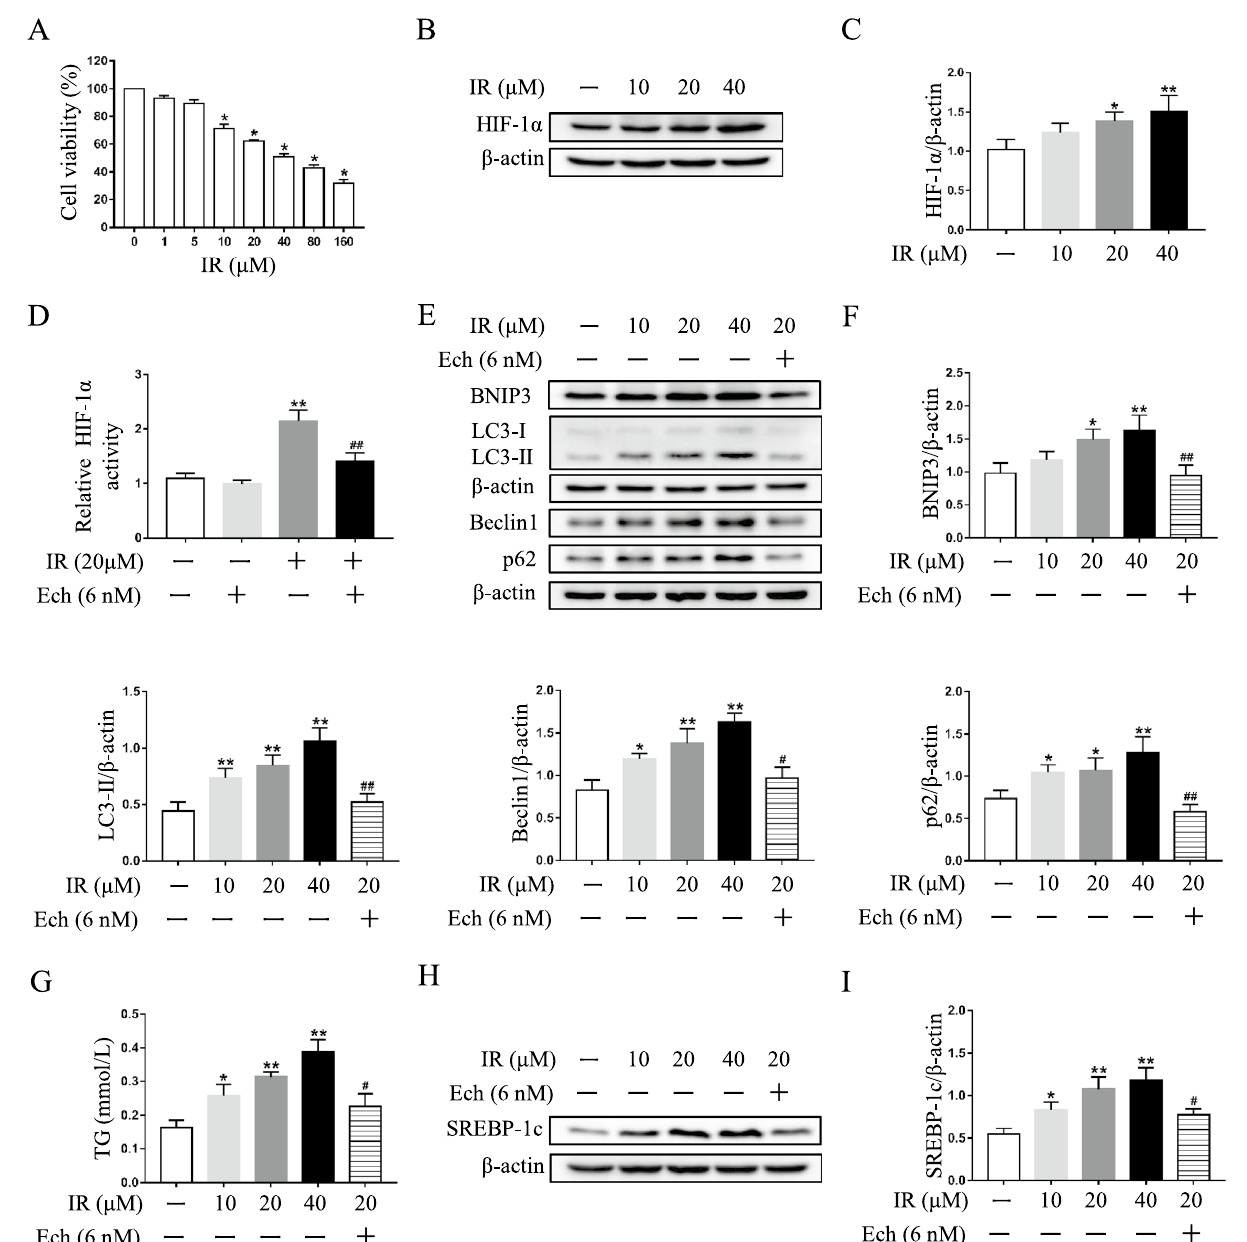
Figure 4. Echinomycin (Ech) mitigates autophagosome accumulation and lipid deposition in irinotecan (IR)-treated HepG2 cells. HepG2 cells were exposed to media supplemented with IR (10, 20, 40 μM) for 12 h-treatment and Ech (6 nM) were given during the last 6 h of 12 h-treatment. ( A ) Cell viability of HepG2 cells treated with different concentrations of irinotecan is measured by CCK8 assay. Data are presented as mean ± SD (n = 6), * P < 0.05 compared with 0 μM group. ( B ) Western blot analysis of HIF-1α protein level in HepG2 cells. (C) Densitometric quantification of HIF-1α. ( D ) Relative HIF-1α DNA binding activity in each group. ( E ) Western blot analysis of BNIP3, LC3-II, Beclin1 and p62 protein levels in HepG2 cells. ( F ) Densitometric quantification of BNIP3, LC3-II, Beclin1 and p62. ( G ) IR exacerbated TG content in HepG2 cells and co-treated with Ech decreased cellular TG content. ( H ) Western blot analysis of SREBP-1c protein level in HepG2 cells. ( I ) Densitometric quantification of SREBP-1c. The blots were cut prior to hybridisation with indicated primary antibodies. Data are presented as mean ± SD (n = 3), * P < 0.05 and ** P < 0.01 compared with normal control group, # P < 0.05 and ## P < 0.01 compared with 20 μM IR-treated